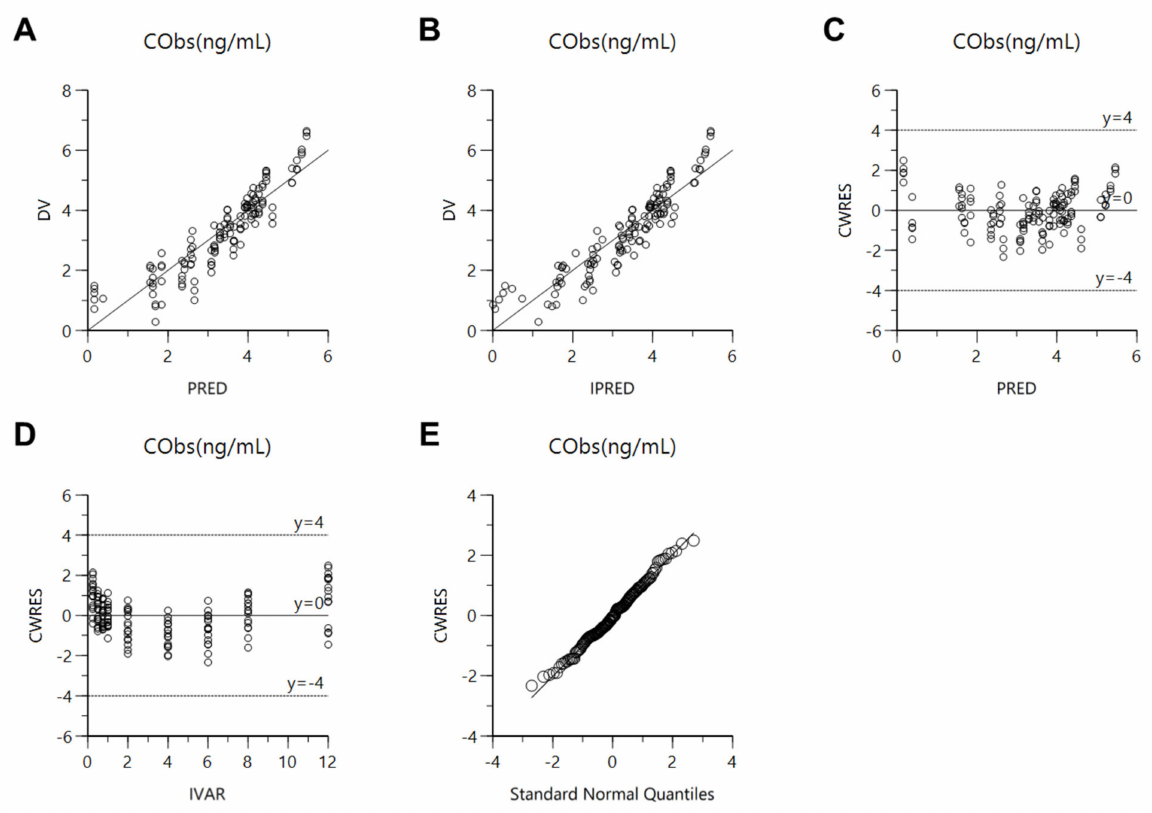
Figure 8. Goodness-of-fit plots of the final population pharmacokinetic model for methotrexate-loaded nanoformulations. ( A ) Population-predicted concentrations (PRED) vs. observed plasma concentration (DV); ( B ) Individual-predicted concen- trations (IPRED) vs. DV; ( C ) PRED vs. CWRES; ( D ) Time (IVAR) vs. CWRES; ( E ) Quantile–quantile plot of the components of